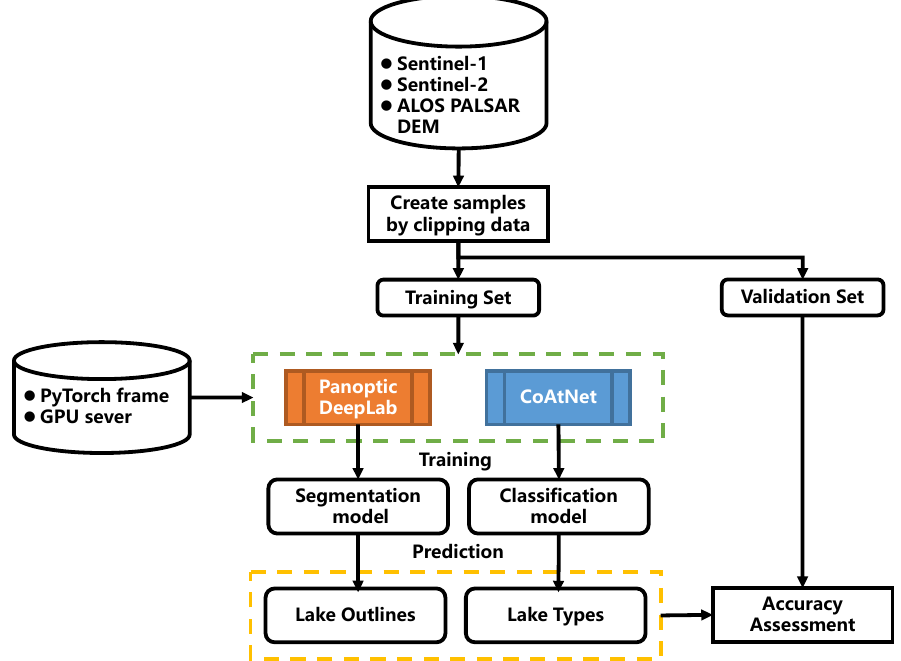
Figure 4. Flow diagram of the methods in the study.